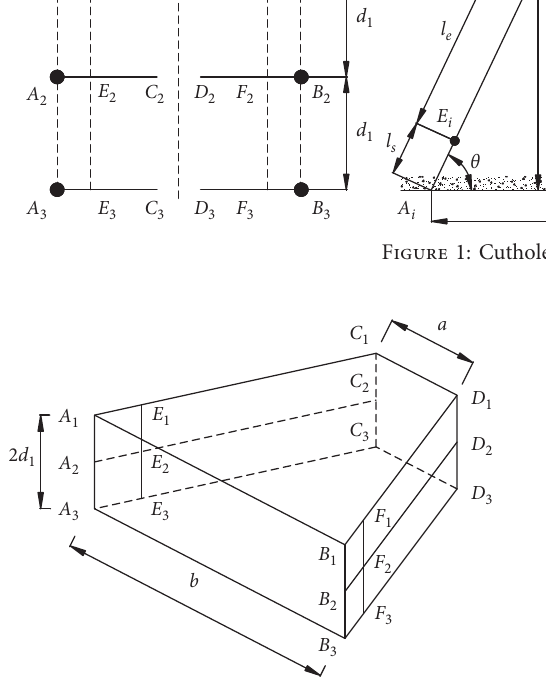
Figure 2: 3D model of horizontal single V-cut blasting